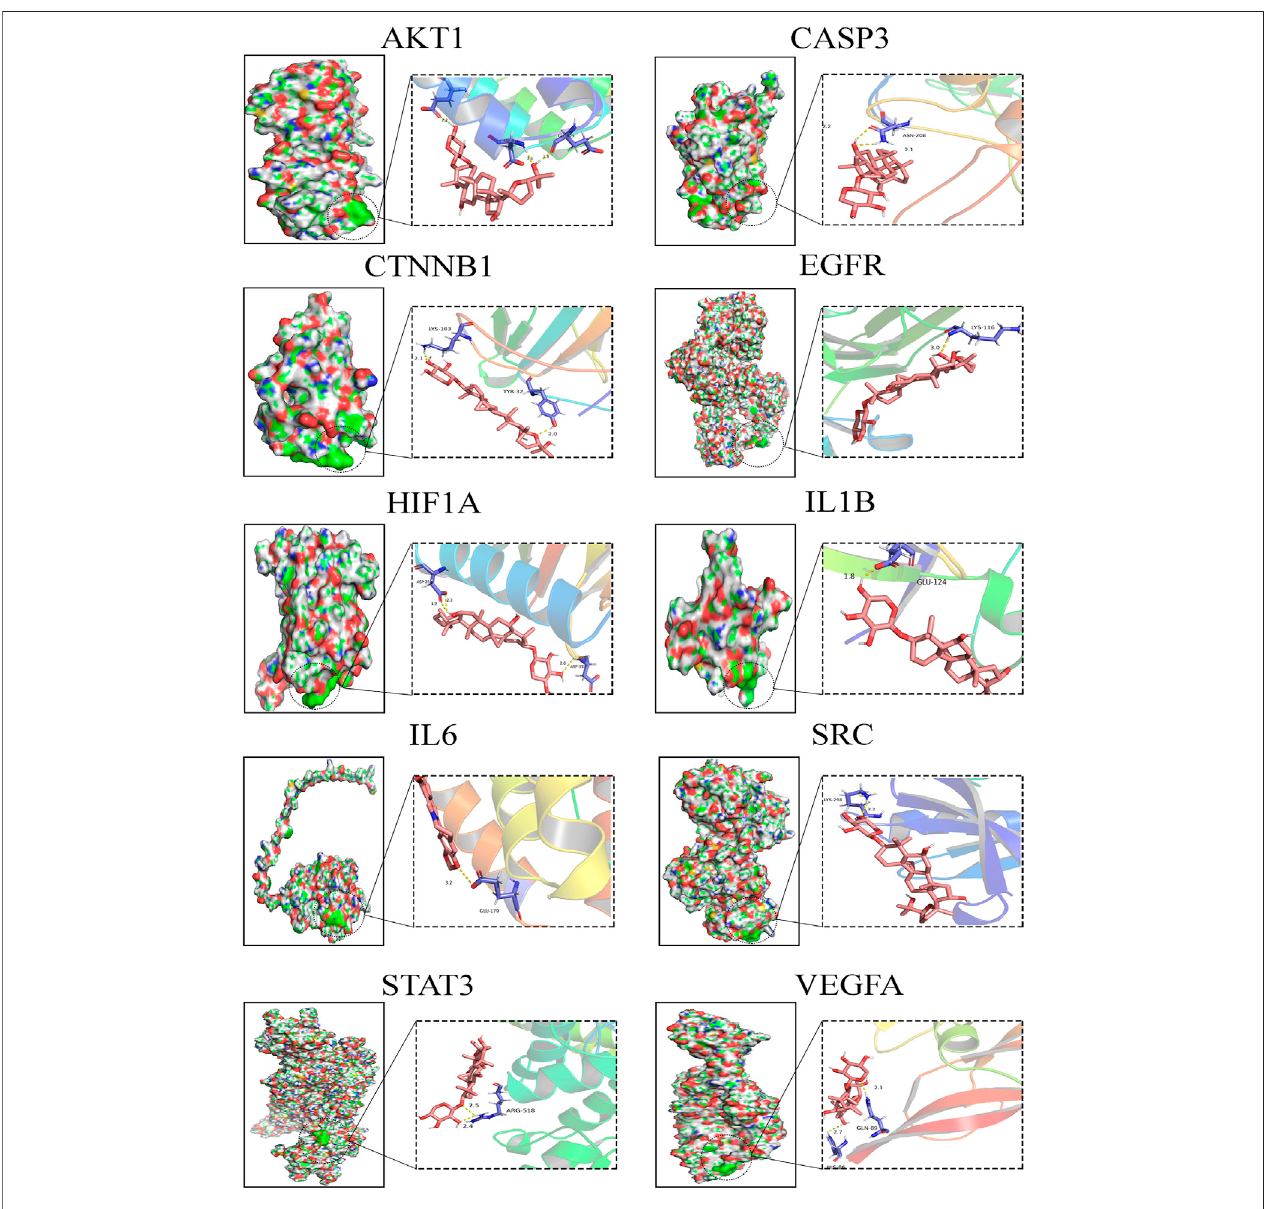
FIGURE 6 | Molecular docking diagrams of AS-IV and hub